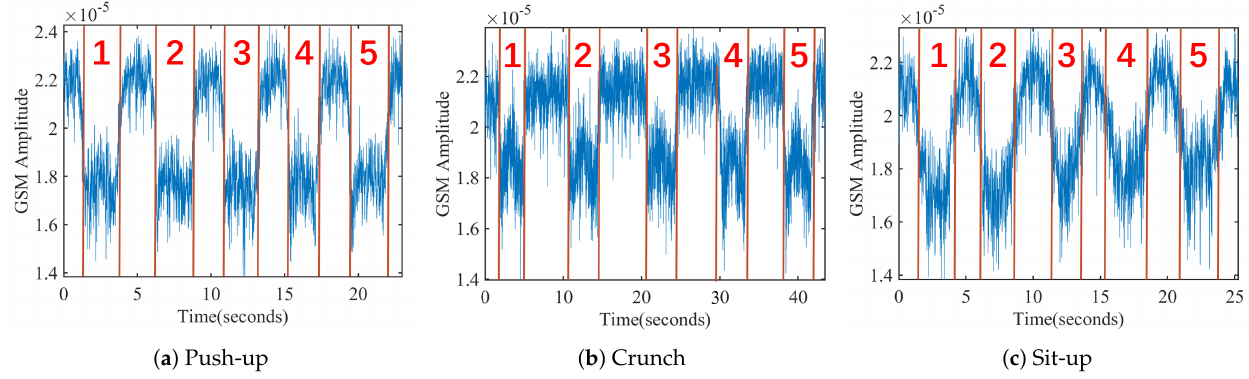
Figure 6. Signal sequences of three different freehand